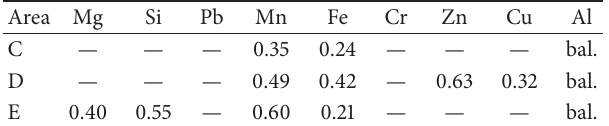
Table 1: EDS results/chemical composition of the precipitates